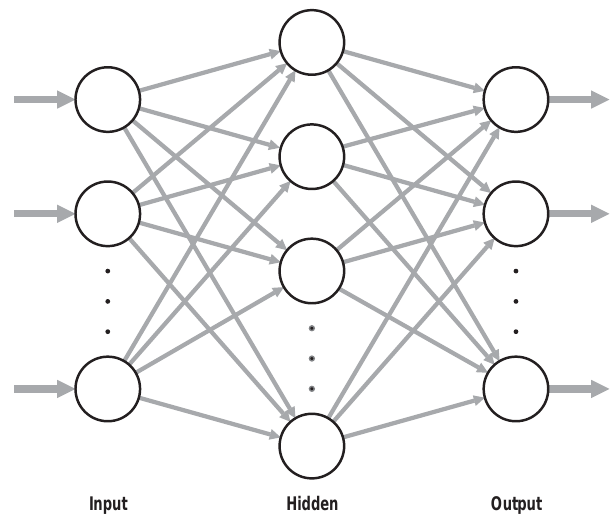
Fig. 1. A three-layered mul tilayer perceptron